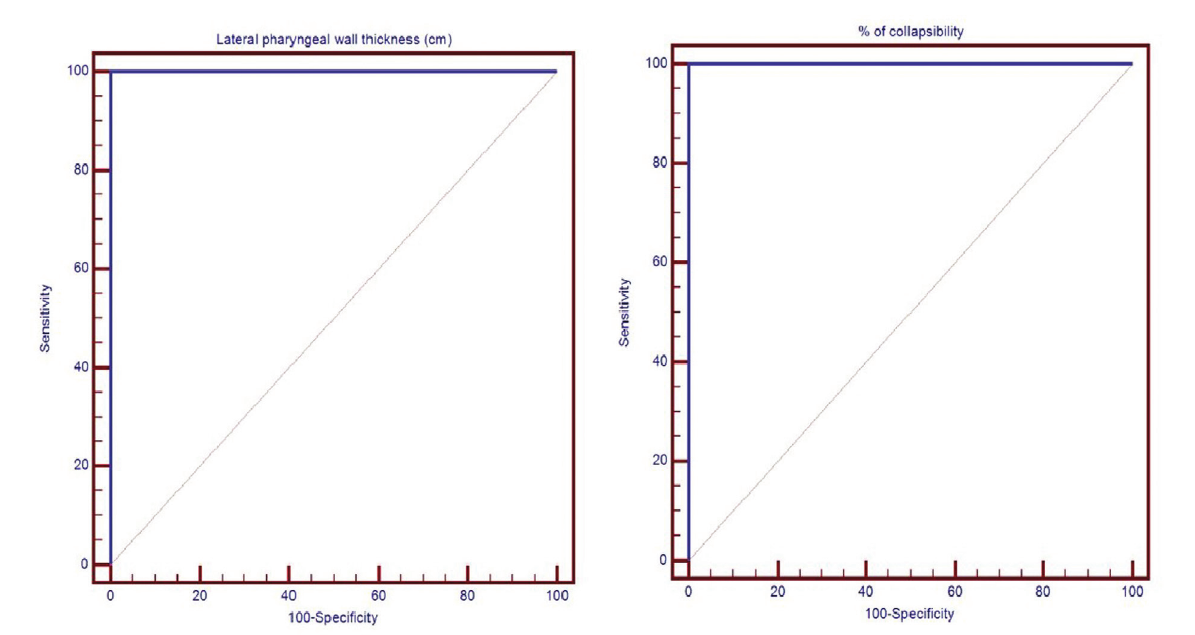
Receiver operator characteristic for different sonographic parameters among the nonintubated patients.